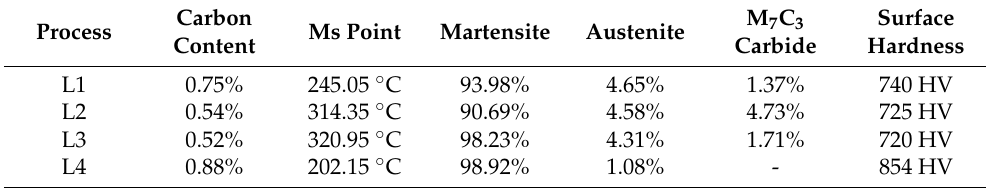
Figure 8. XRD pattern at 0.1 mm of the carburized surface layer. Table 3. Comparison of microstructure and property parameters of the different carburizing processes.